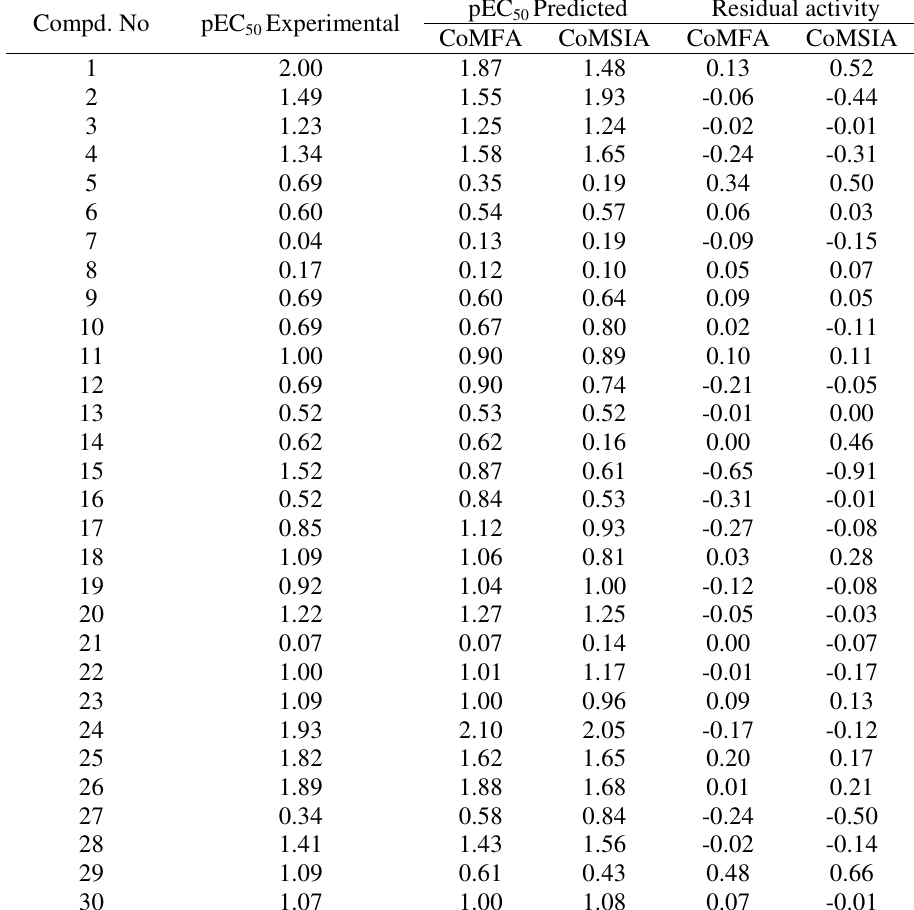
Table 3 . Experimental and predicted inhibitory activities of compounds in training set